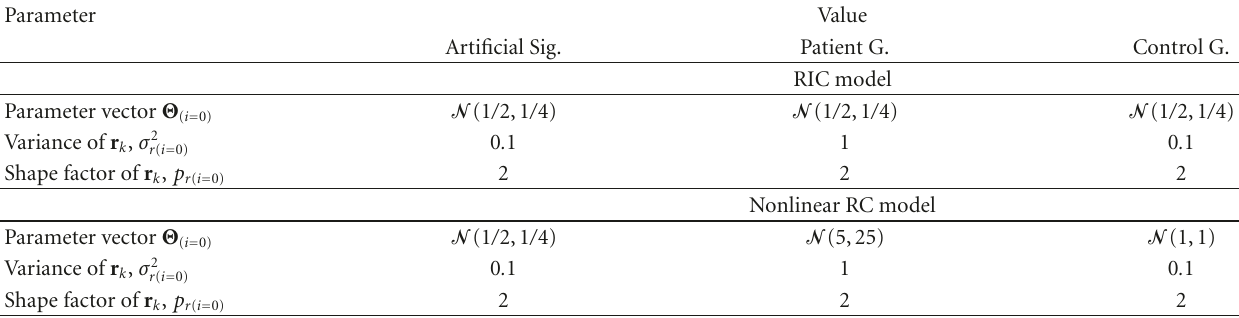
Table 2: Initial values selected for the simulations. N stands for the Gaussian